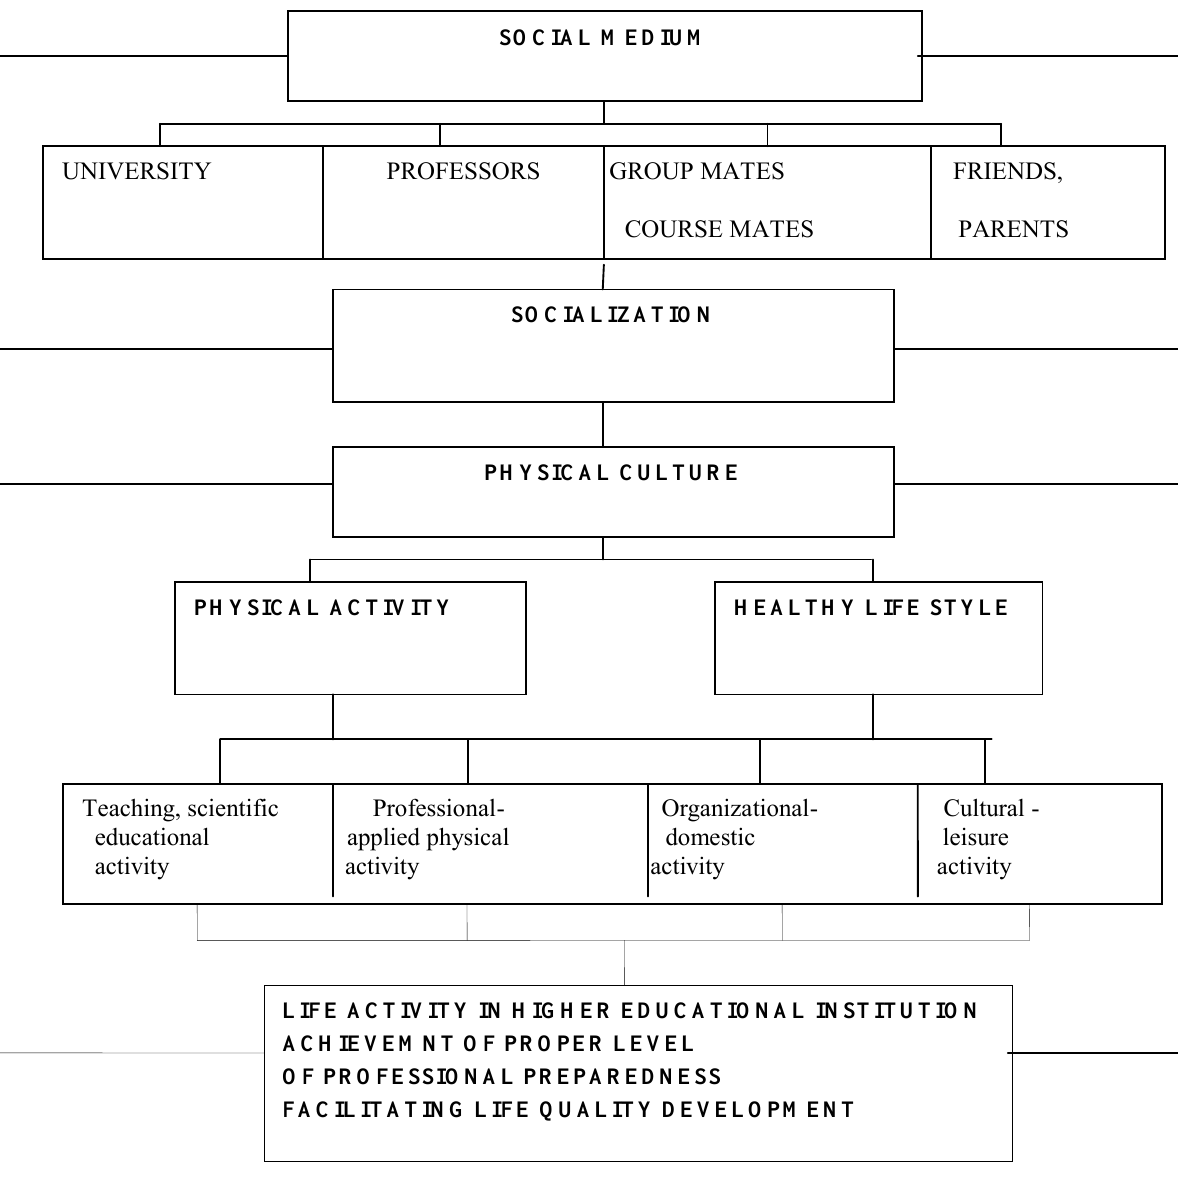
Fig. 1.Social aspects of students physical activity’s formation at higher educa- tional institutions in the aspect of life